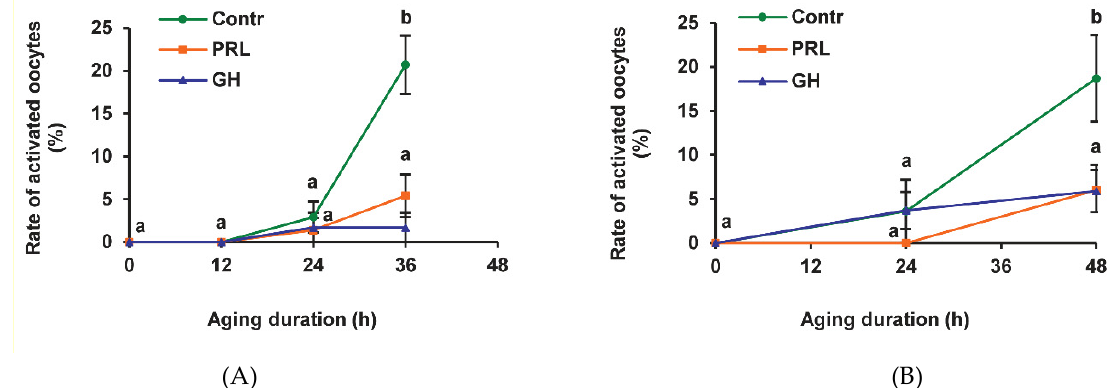
Figure 1. Effects of prolactin (PRL, 50 ng/mL) and growth hormone (GH, 10 ng/mL) on spontaneous parthenogenetic activation during the aging of bovine cumulus-enclosed oocytes (CEOs) ( A ) and denuded oocytes (DOs) ( B ). Data represent means ± SEM of 4–5 replicates using 71–104 oocytes per treatment. Means marked with different letters differ significantly (at least p < 0.05).